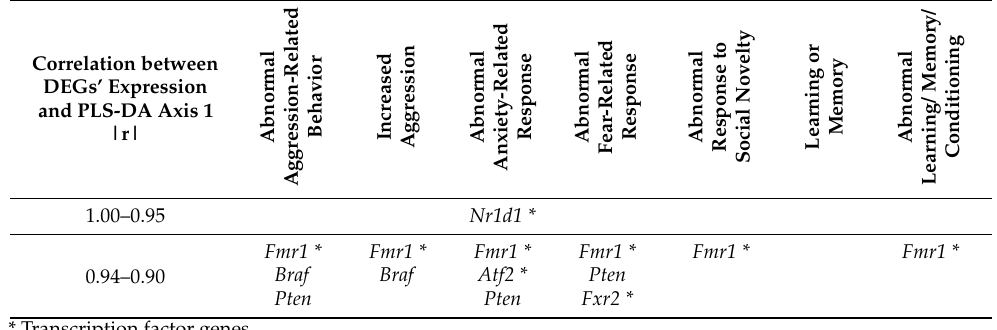
Table 2. Candidate genes associated with neurogenesis and behavioral traits and making the largest contribution to intergroup differences (comparison